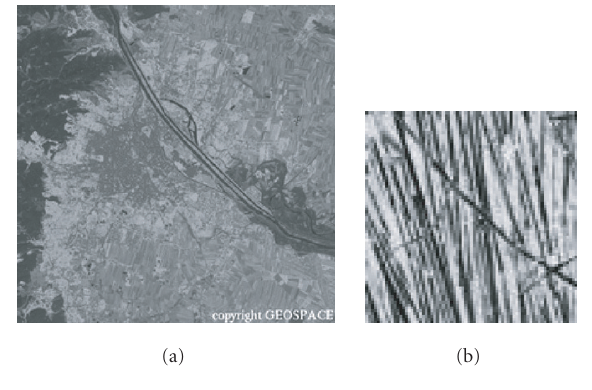
Figure 1: (a) Remote sensing image and (b) nature image.